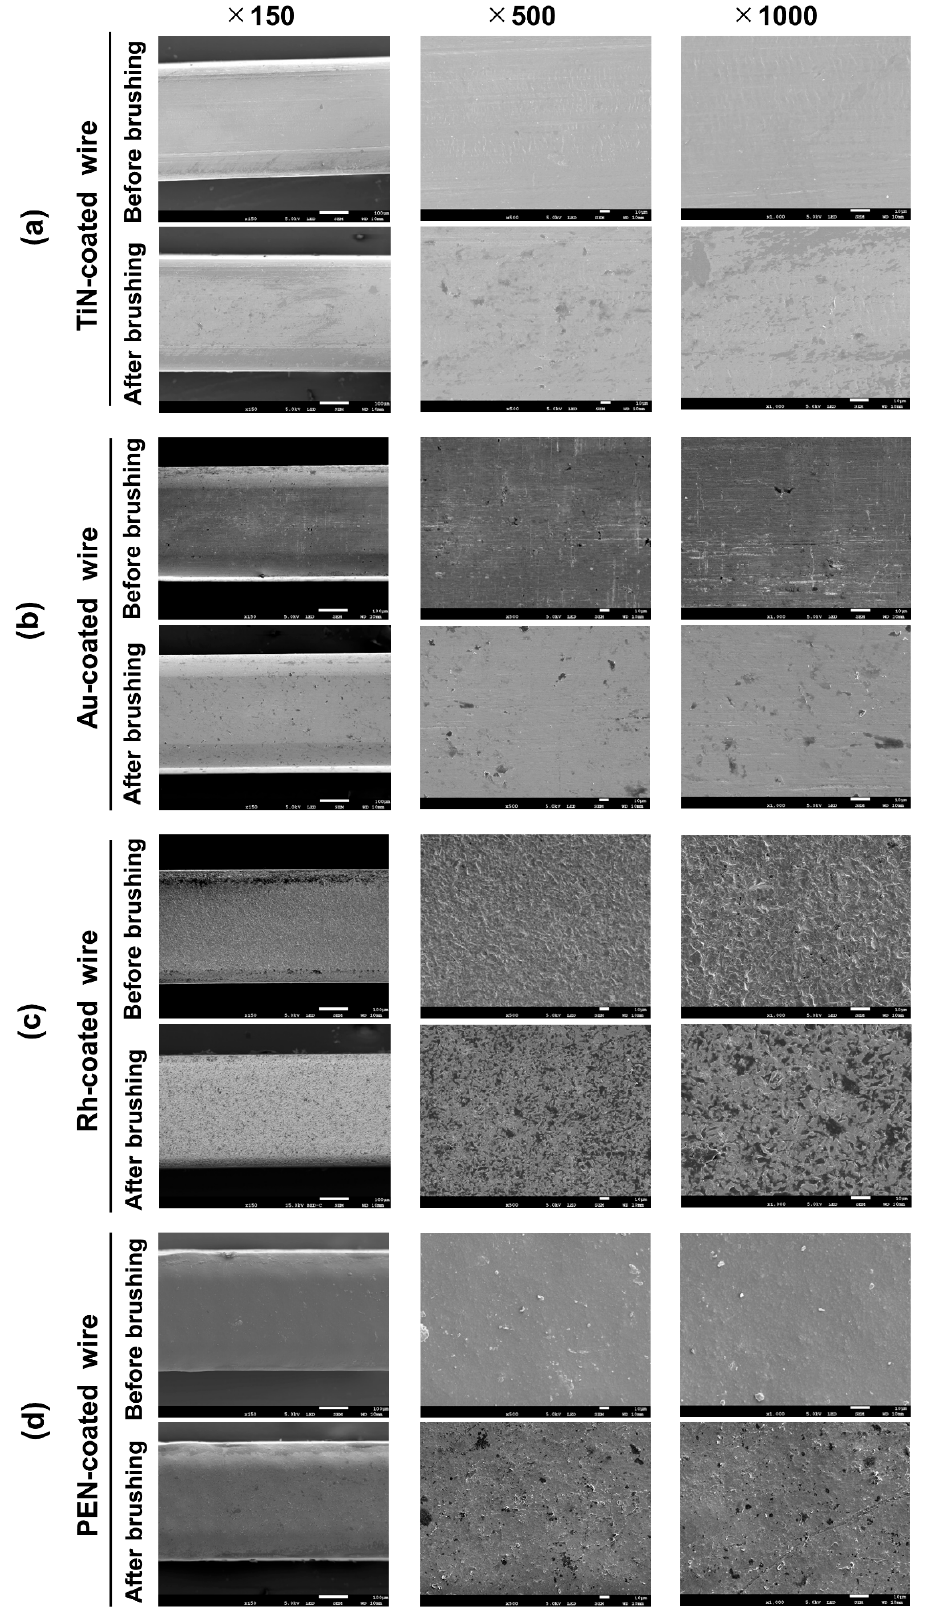
Figure 7. Scanning electron micrographs of four types of coated wire before and after brushing ( × 200, × 500, × 1000 ): ( a ) TiN-coated wire; ( b ) Au-coated wire; ( c ) Rh-coated wire; ( d ) PEN-coated